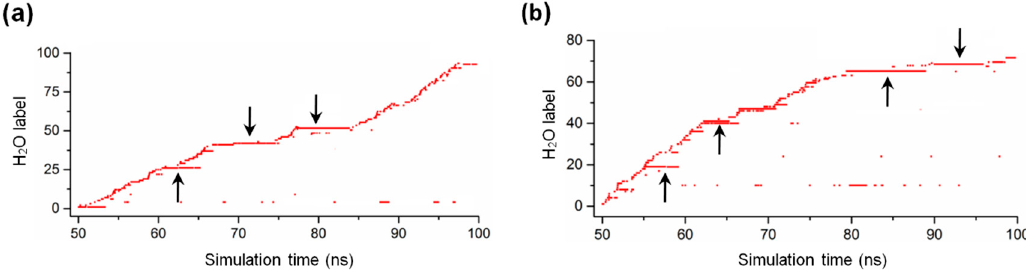
Figure 9. Water dynamic in MreB active site. ( a ) Time spent by water molecules in the catalytic zone of the ATP+ MreB filament. ( b ) Time spent by water molecules in the catalytic zone of the ATP-A22+ MreB filament. The arrows point to long-staying water molecules.